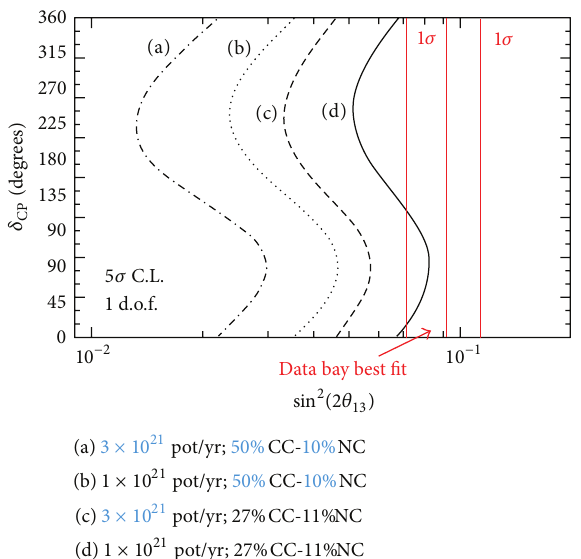
Figure 27: Sensitivity of LENA to the neutrino mass hierarchy for the 2288 km long-baseline CERN to Pyh¨asalmi and for different detector and beam performances at 5𝜎 CL Detector performance parameters like the NC rejection efficiency are still under investi- gation